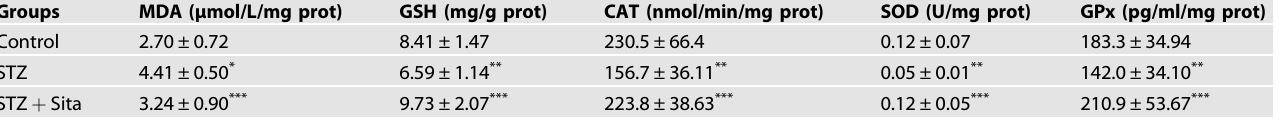
Table 1. Effects of sitagliptin on oxidative stress markers and antioxidant enzymes in liver tissue of mice. Groups